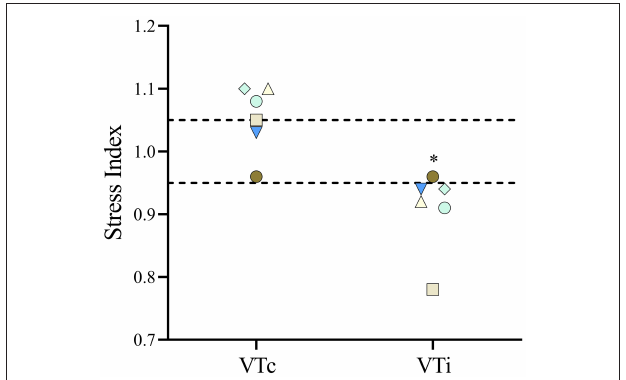
FIGURE 8 | The stress index was calculated in six obese dogs undergoing anesthesia receiving a tidal volume based on current (VTc) and ideal (VTi) body weight. In the figure, each dog is represented by the same symbol and color during both tidal volumes. * p =